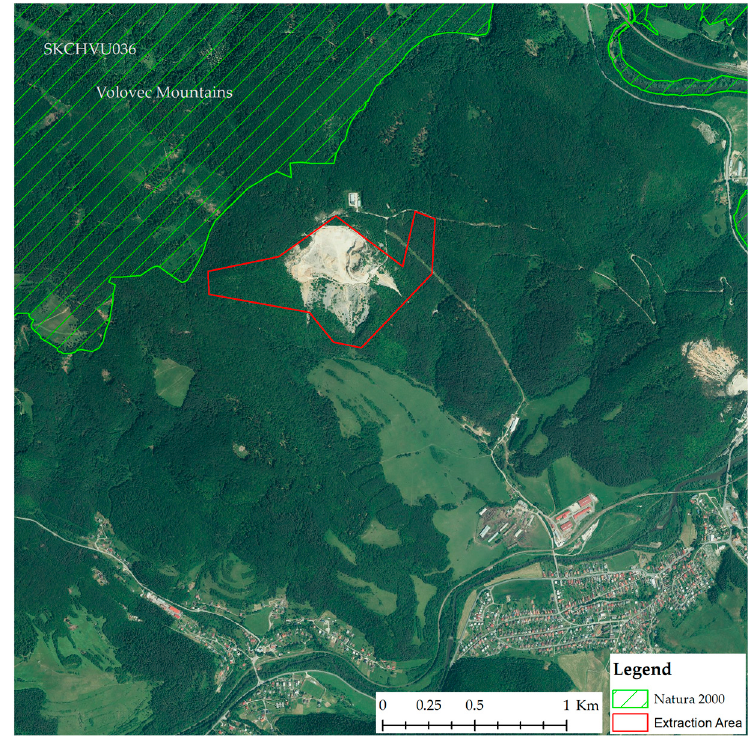
Figure 13. The relative position of the protected bird area and open-pit mine Kurt rock.